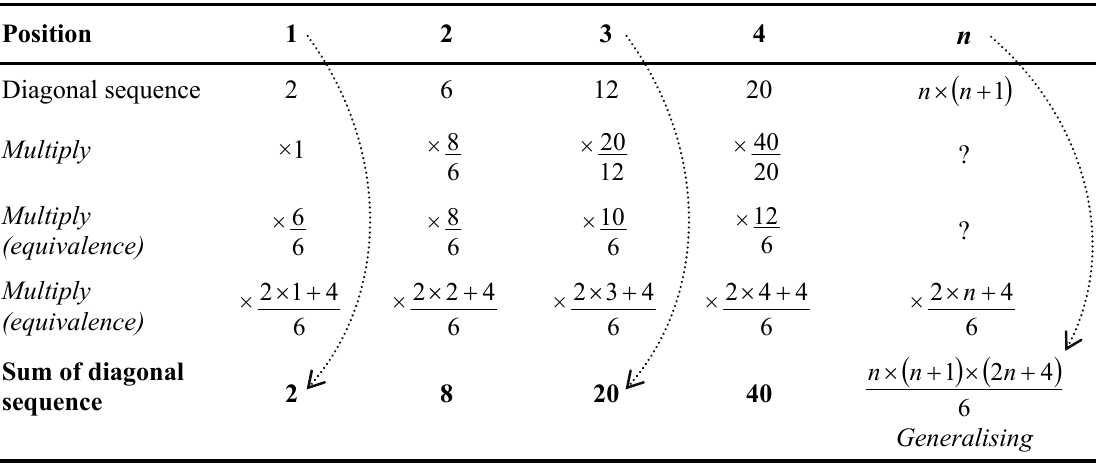
Figure 12 : Seeking a formula for the sum of the diagonal sequence 2, 8, 20, …